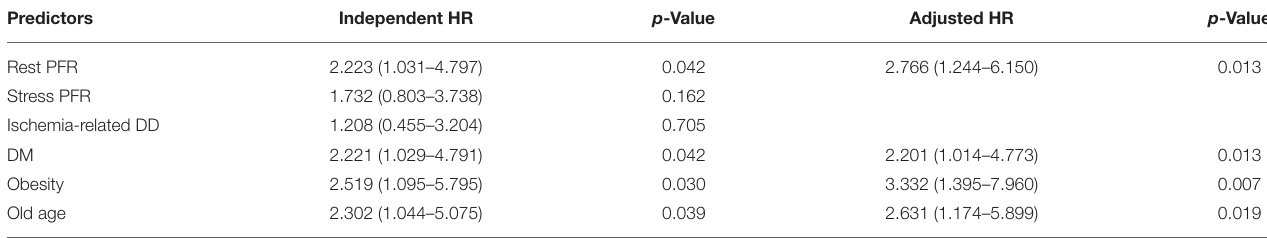
TABLE 4 | Independent predictors of